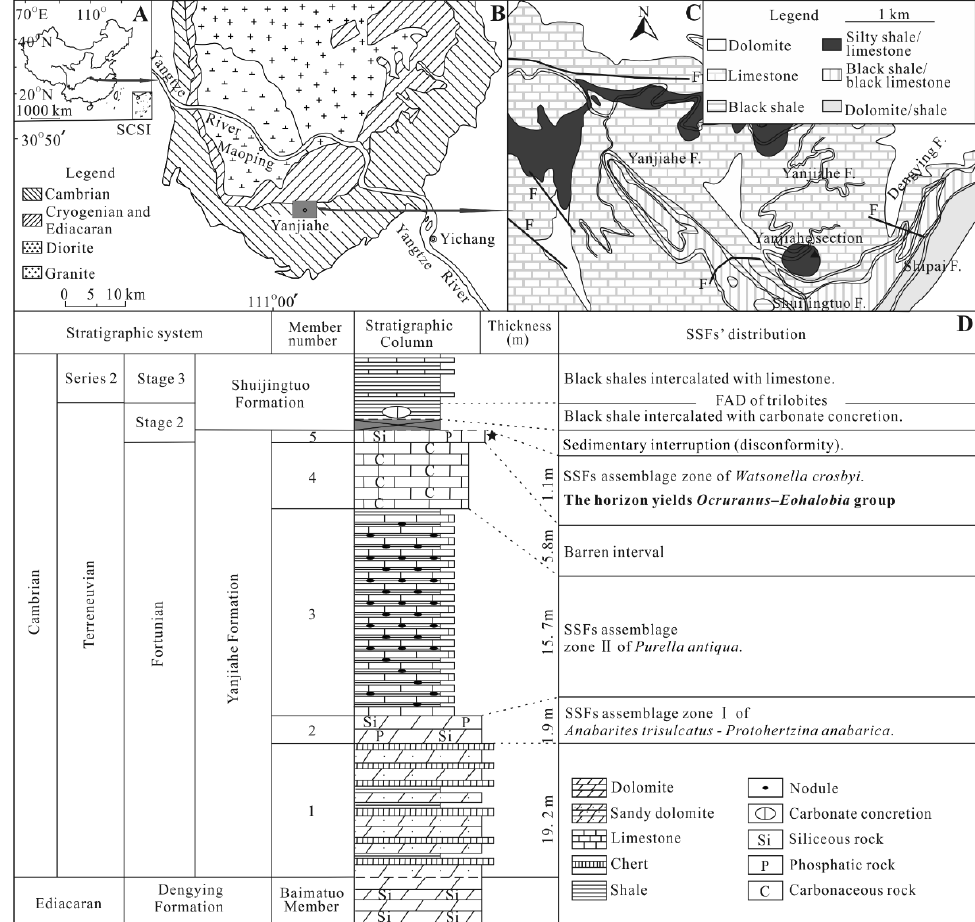
Figure 1. Location and stratigraphy of the Terreneuvian Yanjiahe Formation in the Three Gorges area, Hubei Province, China (modified from [14]). ( A ) Sketch map of the People’s Republic of China, showing the position of the collecting locality in Hubei Province. ( B ) Simplified geological map of the Three Gorges area, Hubei Province, showing the outcrops of the Cambrian strata (gray box in the Yanjiahe area denotes area enlarged for additional details). ( C ) Detailed geological map of the Yanjiahe area, showing the outcrops of the Yanjiahe Formation. ( D ) Stratigraphic sequence of the Yanjiahe Biota in the Yanjiahe section, Yangtze Gorges area, indicating the horizon where specimens of Ocruranus and Eohalobia sclerites were collected.